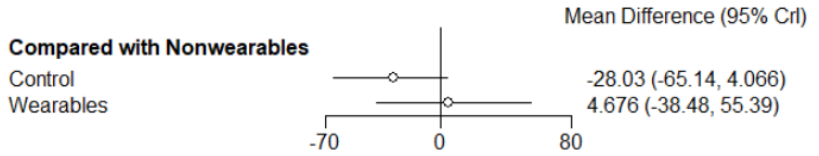
Figure 4. Forest plots suggested no significant improvement of walking distance change score (reported as 6MWD and MWD) in participants who used wearables compared to non-wearables group. Results are expressed as mean difference (95% CrI) in metres. Crl: Credible interval. 6MWD—Six-minute walking distance; MWD—Maximum walking distance.